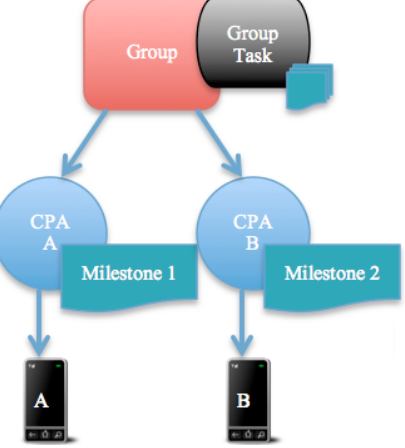
Figure 4. A group within the CAMCS middleware receives a group task. The group task has several milestones, two of which, have been assigned to two different CPAs. Details of each are sent to the user’s mobile